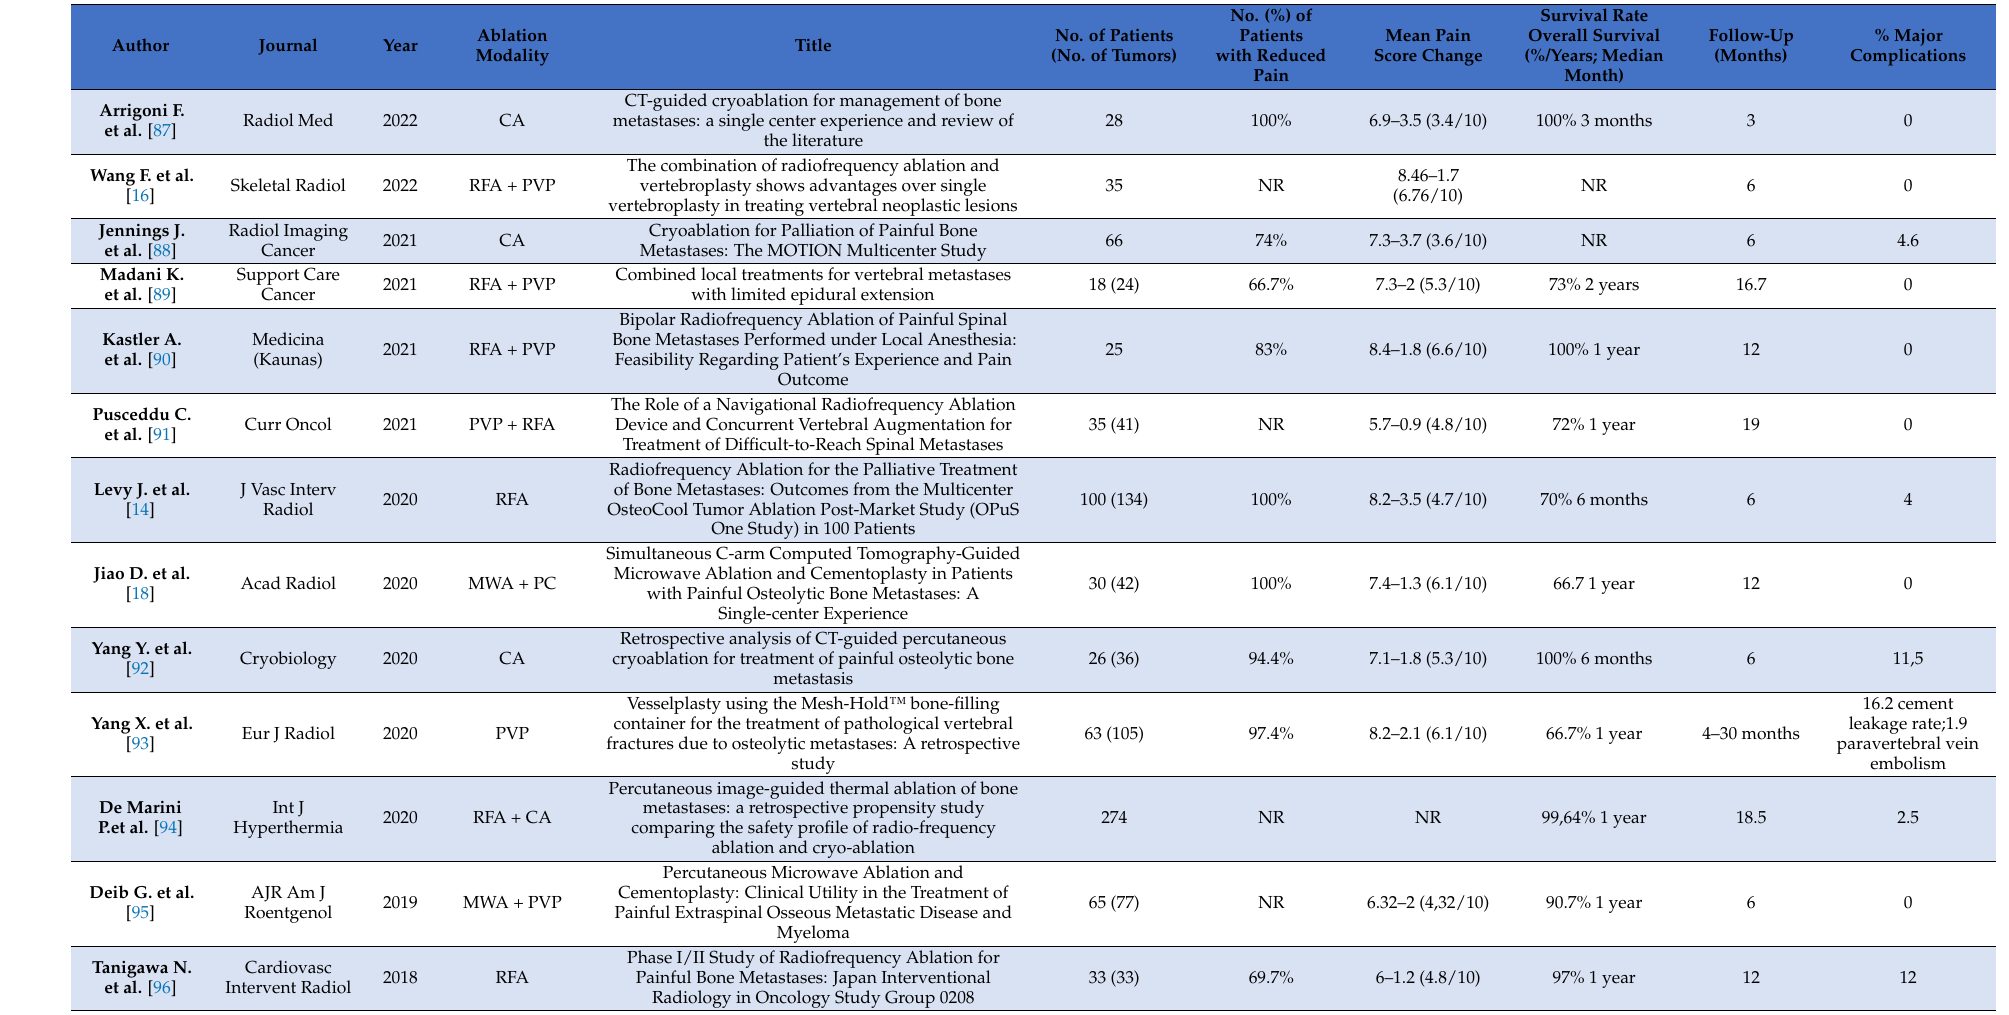
Table 3. Results of palliative ablation and combined of the treatment of bone fracture and impending fracture, main results